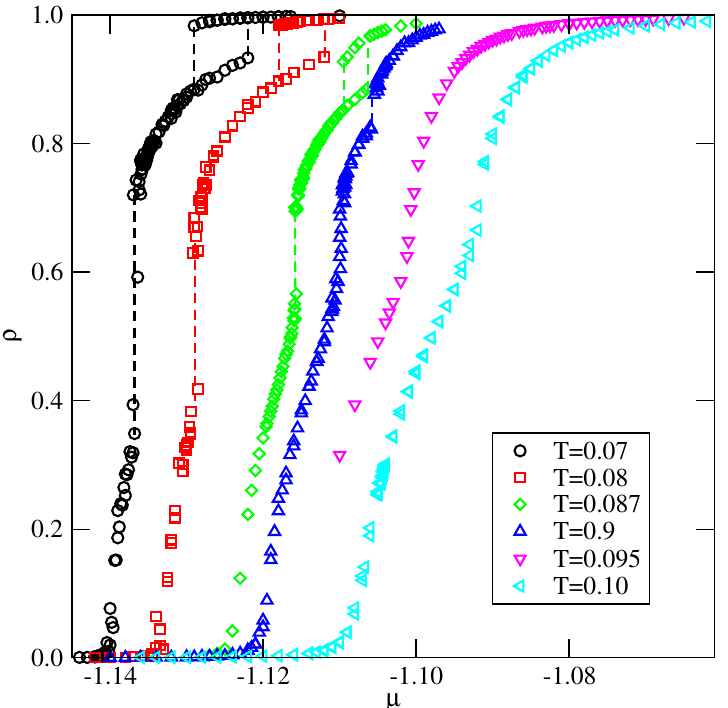
Figure 9. The isotherms obtained for the system with u ∗ = − 0.01 at different